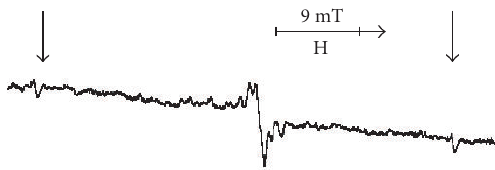
Figure 3: The ESR spectrum with five superfine components ( Δ H = 1 . 16mT, g -factor 2 . 003) of irradiated acetic acid solution (pH 3 . 7; 77 K). (The arrows indicate a doublet ( Δ H ∼ 50 . 6 mT) of hydrogen